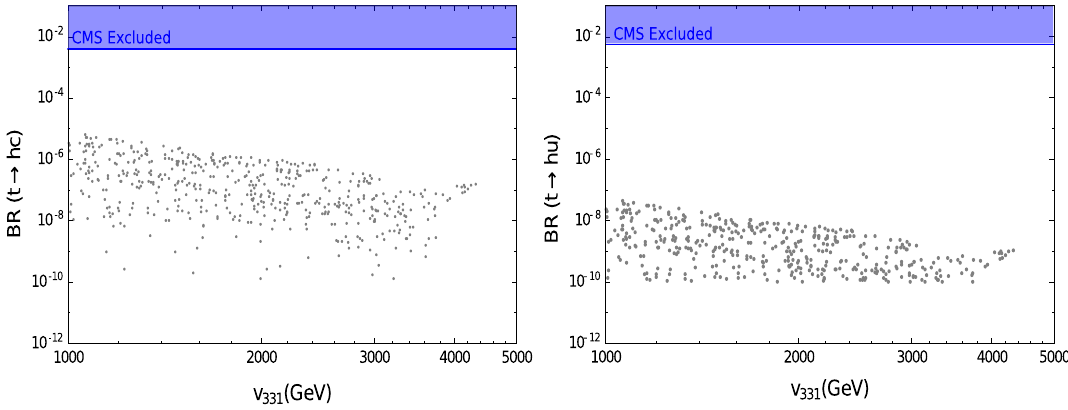
Fig. 6 Calculation of the branching ratios for the top decays t → hc and t →